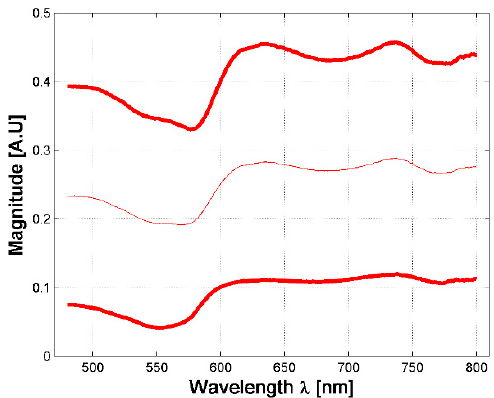
Figure 3. Variations in measured diffuse reflectance spectra from all hamsters. Light color line corresponds to the mean spectra. Bold lines correspond to the spectra obtained from the 3 sigma rule.